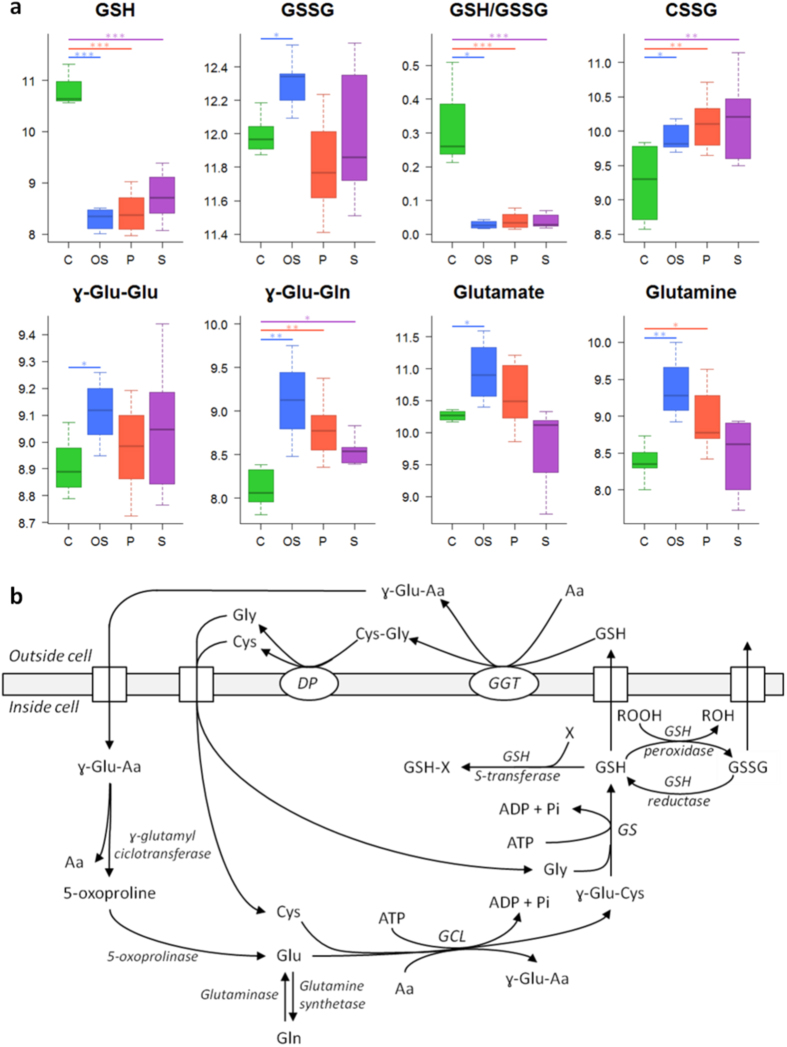
Metabolic alterations related to GSH metabolism and the γ-glutamyl cycle.(a) Boxplots showing the altered metabolites. Boxes denote interquartile ranges, lines denote medians and whiskers denote the 10th and 90th percentiles. Metabolite relative abundance, expressed as ratio or log-transformed, is calculated by referring metabolite peak intensity to a constant concentration of internal standard per mg of tissue. Green: control (C); blue: oxidative stress (OS); red: phospholipidosis (P); purple: steatosis (S). *, q value < 0.05; **, q value < 0.01; ***, q value < 0.001 calculated using the Mann Whitney test corrected for multiple testing by using FDR. (b) The γ-glutamyl cycle, which accounts for GSH synthesis and recycling. Enzymes are denoted in italics. Square boxes denote transmembrane transporters. Aa: amino acid; Cys: cysteine; Cys-Gly: cysteinyl-glycine; DP: dipeptidase; GCL: glutamate cysteine ligase; γ-Glu-Aa: γ-glutamyl amino acid; GGT: γ-glutamyl transpeptidase; Glu: glutamate; Gly: glycine; GS: glutathione synthetase.